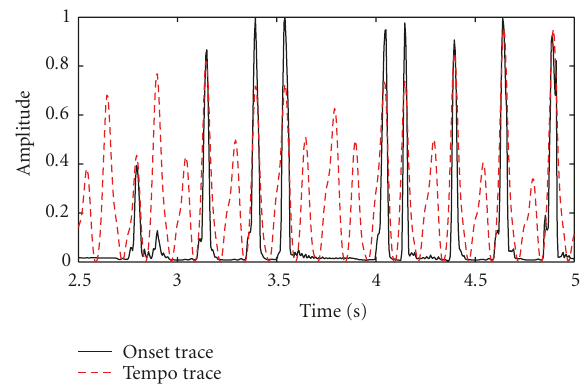
Figure 11: The onset trace shows the merged output of the neu- ral networks as in Figure 10. The tempo trace shows the cross- correlation of the onset trace with its own